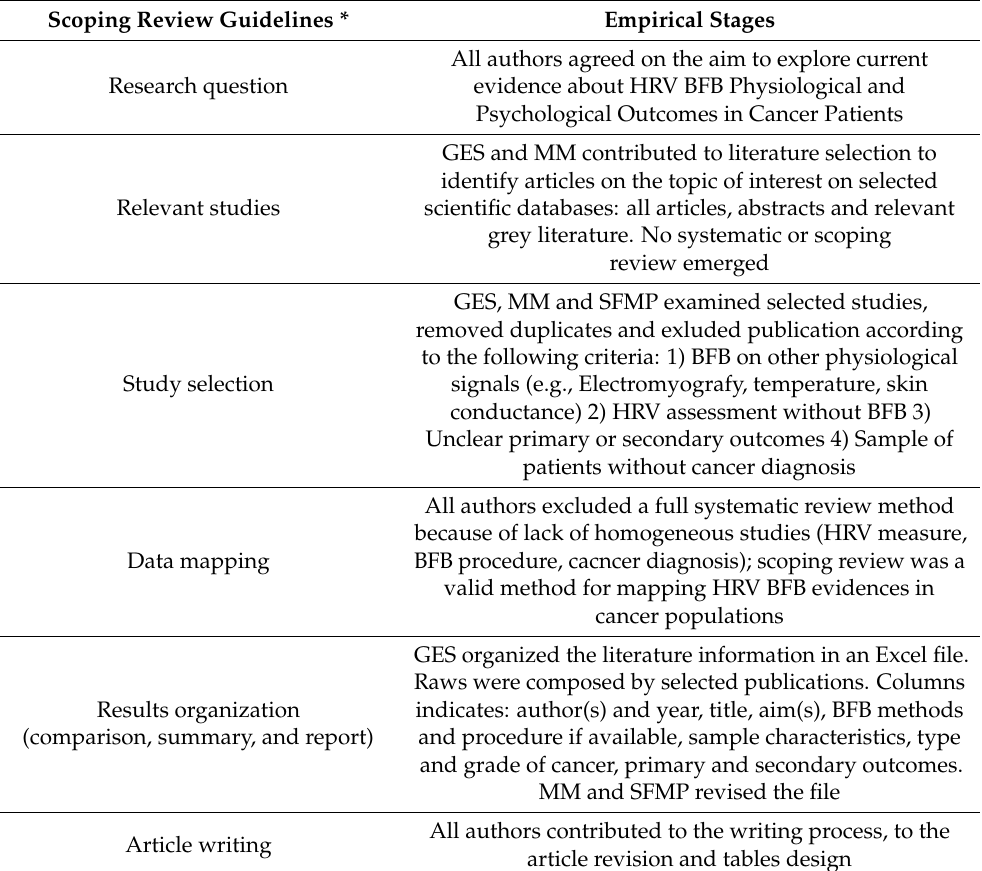
Table A2. Procedure in Scoping Review Analysis and Authors’